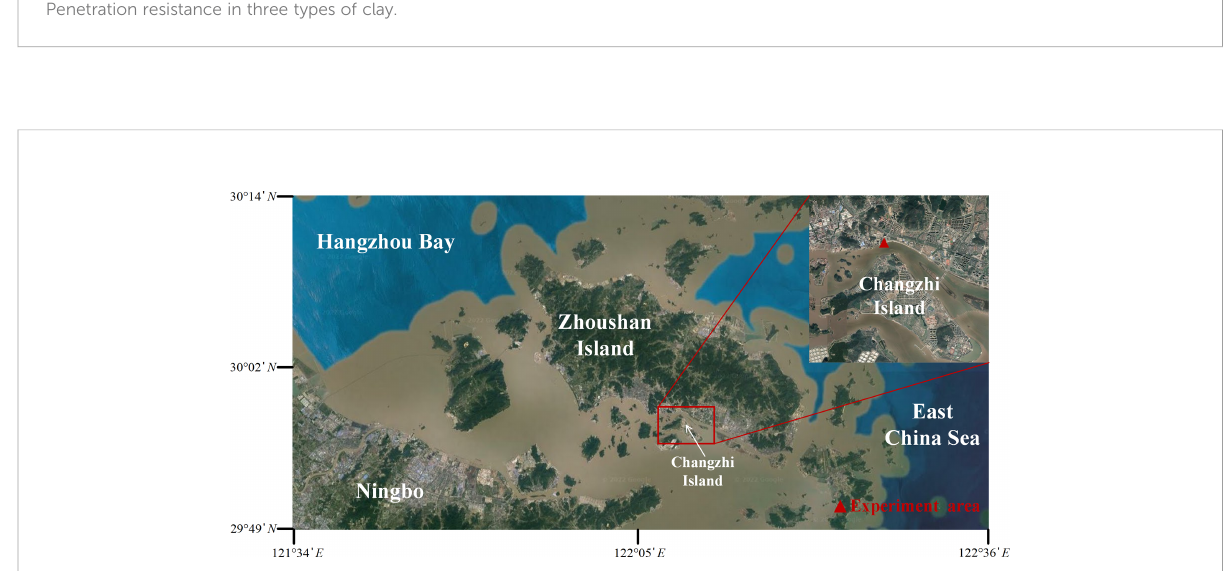
FIGURE 9 The location of the Changzhi Island in Zhoushan Island,